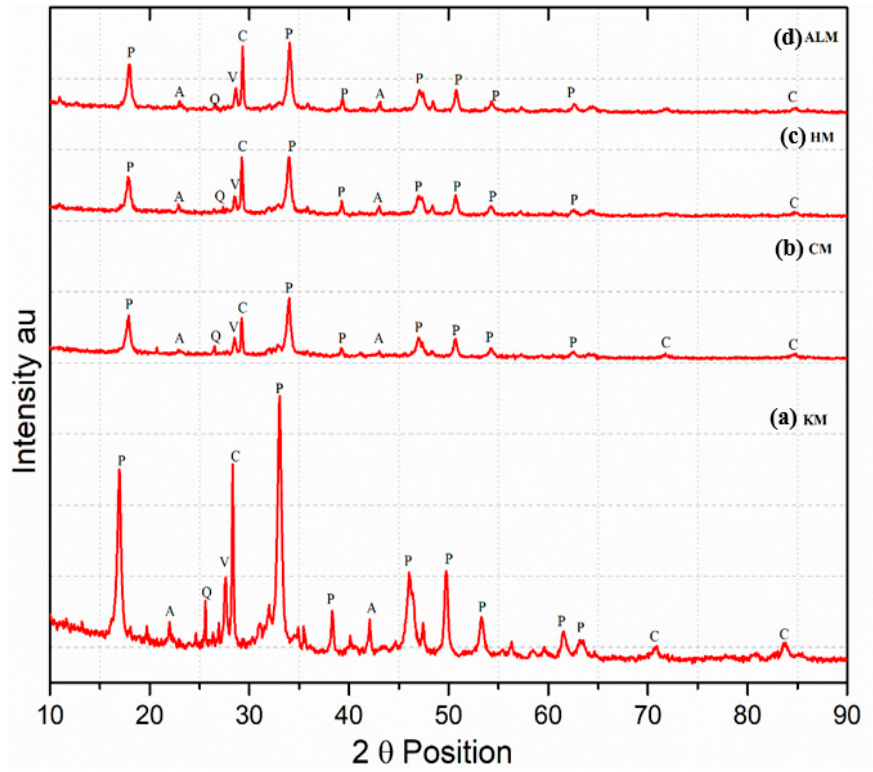
Figure 8. XRD patterns at 28 days: ( a ) kadukkai lime mortar; ( b ) cactus lime mortar; ( c ) hibiscus lime mortar; ( d ) aloe vera lime mortar. P: portlandite, C: calcite, A: aragonite, T: Tobermorite, Q: quartz, V: vaterite, G: gismondine-(CSH).